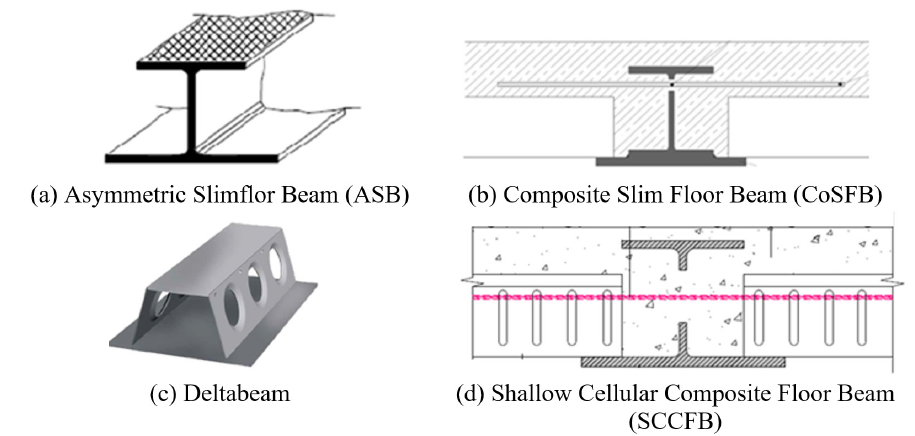
Figure 1. Slim floor